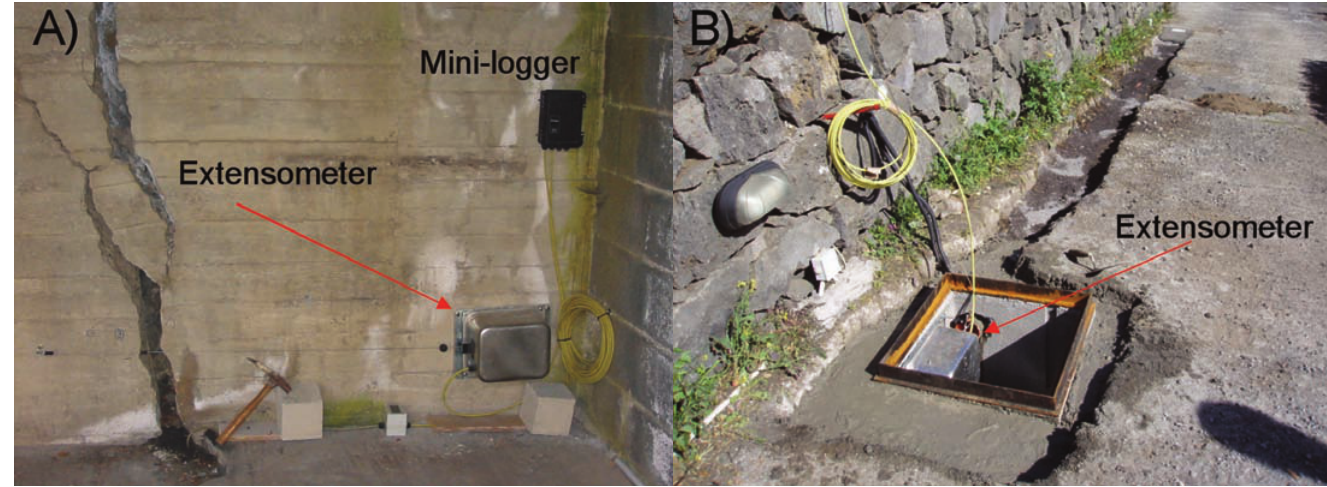
Figure 3. Photographs of the Et1 (A) and Et2 (B) extensometer sites during